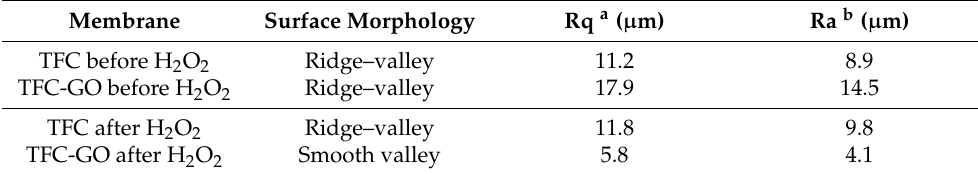
Table 2. Surface characteristics of the fabricated TFC and TFC-GO